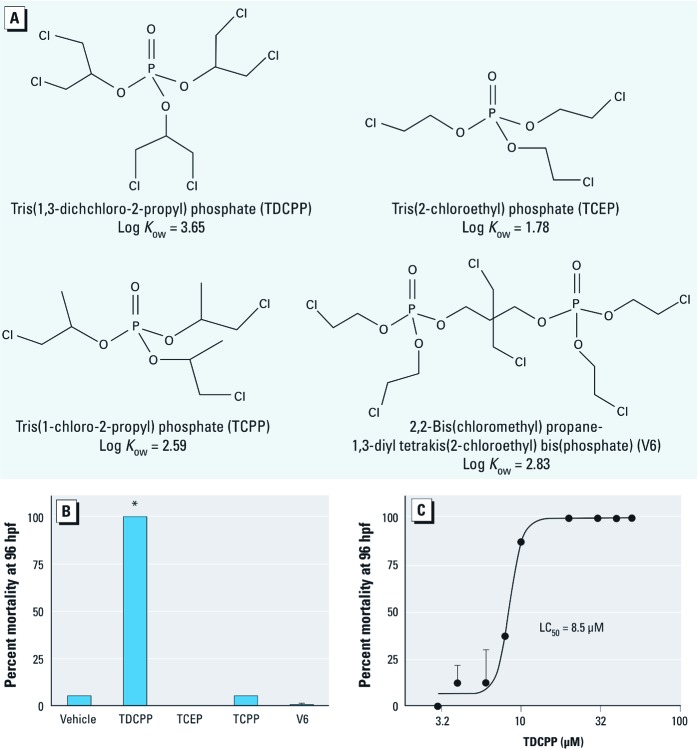
Developmental toxicity of CPE-based FRs during zebrafish embryogenesis. (A) Four structurally related CPE-based FRs screened for toxicity during zebrafish embryogenesis, all of which have been detected in polyurethane foam collected from baby products (Stapleton et al. 2011). (B) Mean percent mortality (± SD) at 96 hpf after static exposure to vehicle (0.1% DMSO) or a CPE (50 μM) during 5.25 hpf (50% epiboly) to 96 hpf (n = 2 beakers/treatment). (C) Four-parameter concentration–response curve fit to mean percent mortality (± SD) at 96 hpf following static TDCPP exposure during 5.25–96 hpf (n = 5 beakers/treatment for 3 and 4 μM TDCPP, and 2 beakers/treatment for the remaining TDCPP doses). *p < 0.05 compared with vehicle controls.